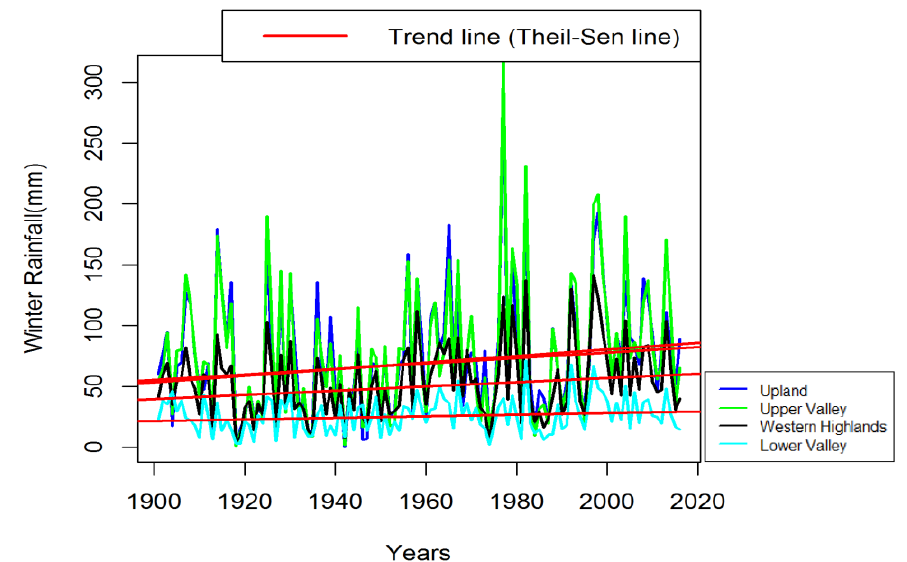
Figure 14. Winter rainfall time series showing significant increasing trends for the period 1900 – 2016.